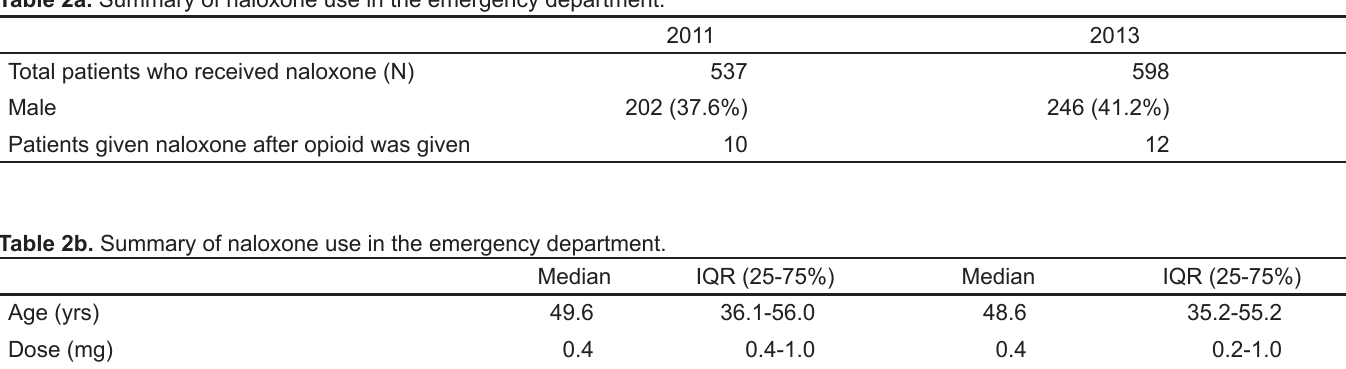
Table 1b. Demographics and composite data in study of opioid administration. department.Median Table 1c. Opioid-specific data.